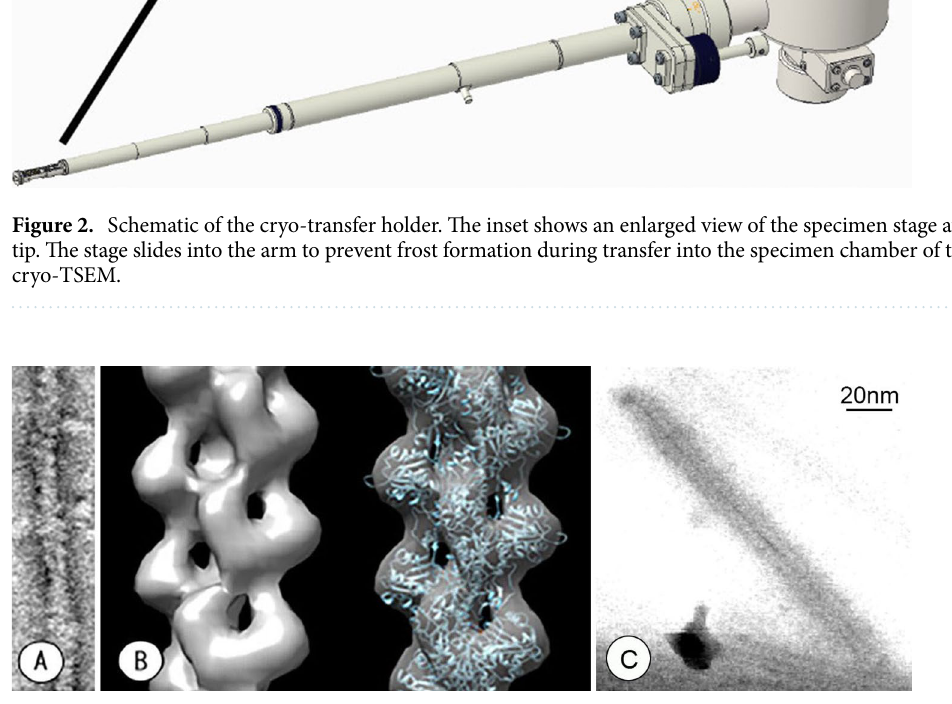
Figure 3. Evaluation of images obtained with STEM optical system installed in the 30-kV TSEM. ( A ) A raw STEM image of negatively stained actin filaments. The short and long periodicities can be observed in high contrast. ( B ) Reconstructed molecular model of actin filaments via image processing of 129 units images (one unit contains approximately 28 monomer conjugates). The molecular mapping 25 derived by X-ray diffraction was superimposed on the reconstructed image (right). This demonstrates that the STEM images had sufficient resolution for imaging intracellular fine structures. ( C ) A raw STEM image of quickly frozen TMV acquired